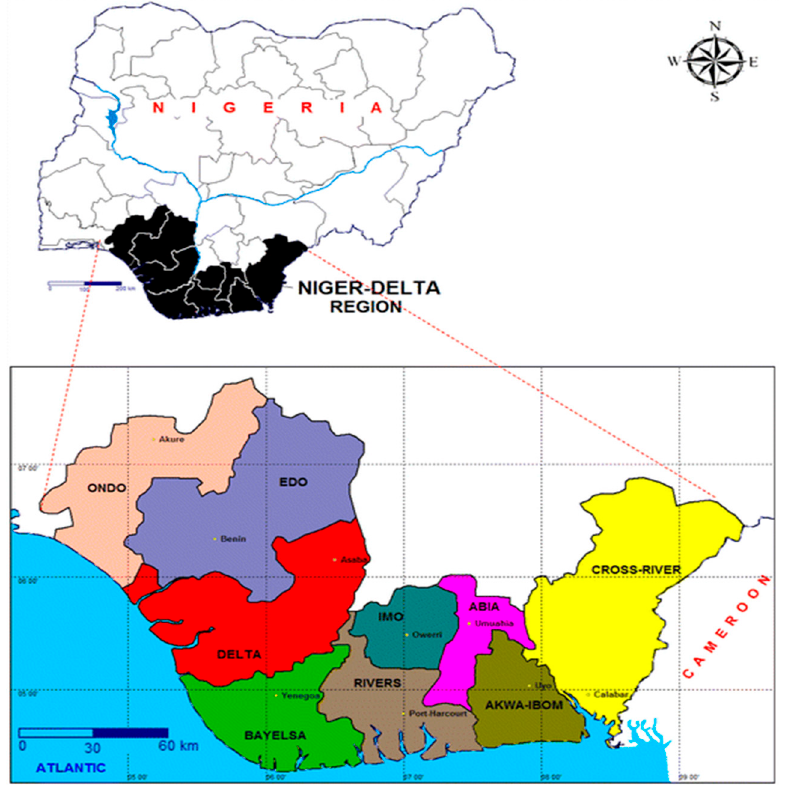
Figure 1. The Niger Delta region of Nigeria. Source: Nzeadibe et al. [22].